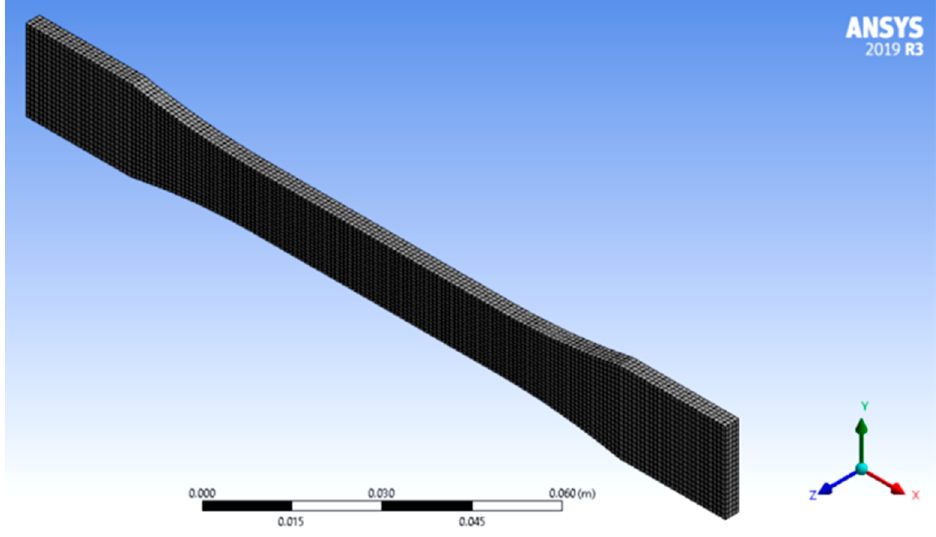
Figure 2. Modelling and meshing of sample using Solidworks .